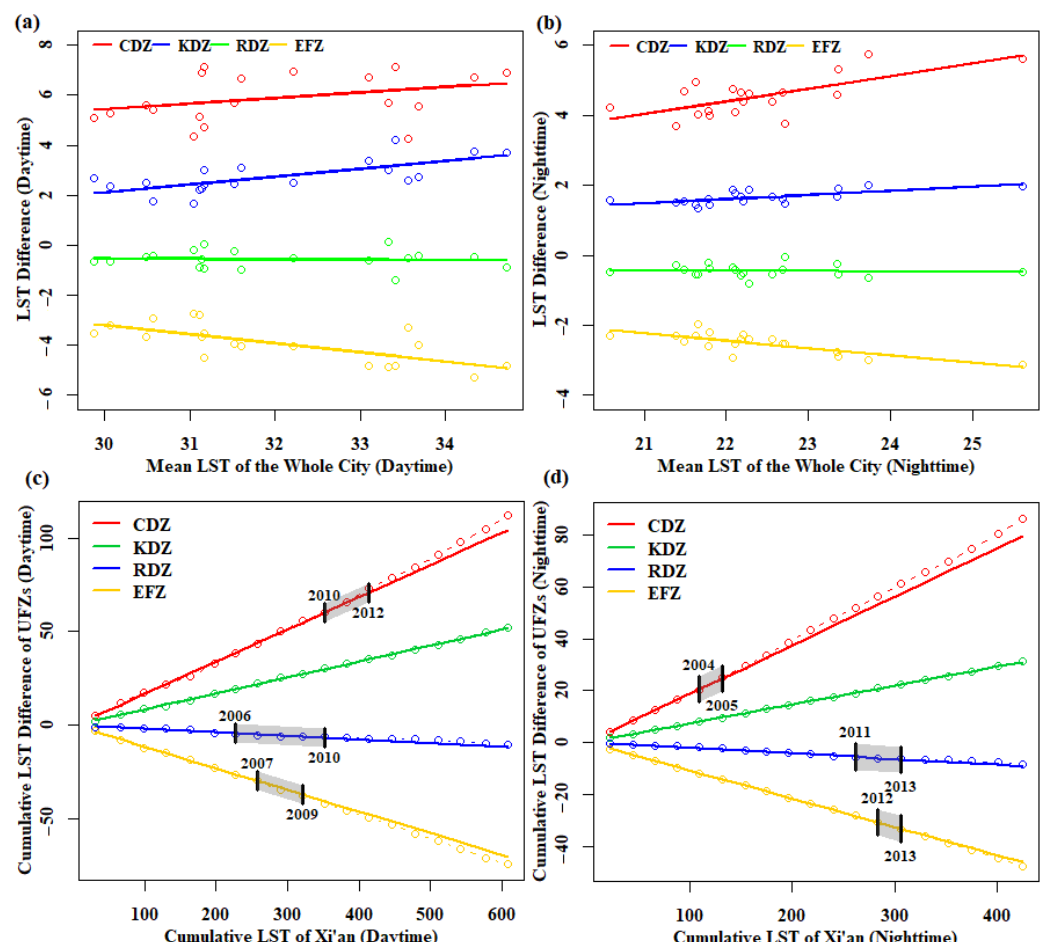
Figure 6. The relationship between LST differences (between each functional zone and Xi’an) and the mean LST for Xi’an ( a , b ) and double temperature curves in cumulative values of LST differences and mean LST values for Xi’an ( c , d ) during daytime and nighttime. The grey area represents the 95% confidence range of the